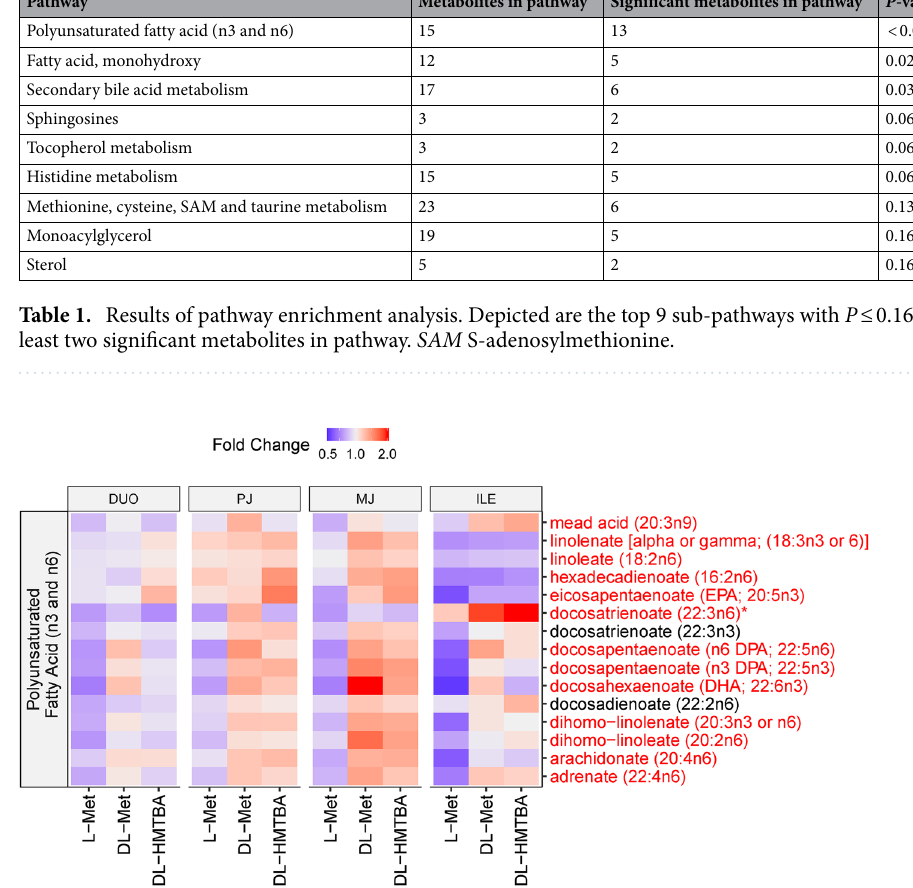
Figure 2. Heat map of the polyunsaturated fatty acids pathway, showing the distribution of all measured pathway-related metabolites along duodenum (DUO), proximal jejunum (PJ), middle jejunum (MJ) and ileum (ILE) in pigs pre-fed with L-Met, DL-Met or DL-HMBTA. The heat map represents the fold changes across tissues as metabolites, which were scaled across all samples. Blue color indicates lower abundance whereas red color indicates higher abundance of metabolites. Red writing of individual metabolites indicates a treatment effect ( P <